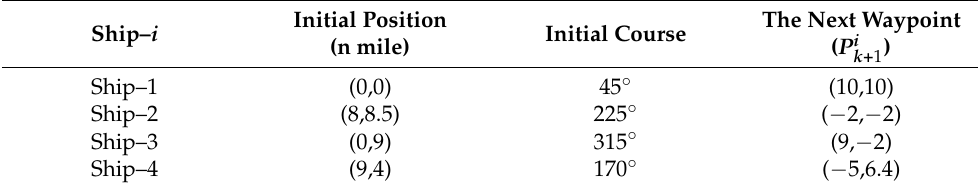
Table 2. The initial state of four ships in scenarios 2 and